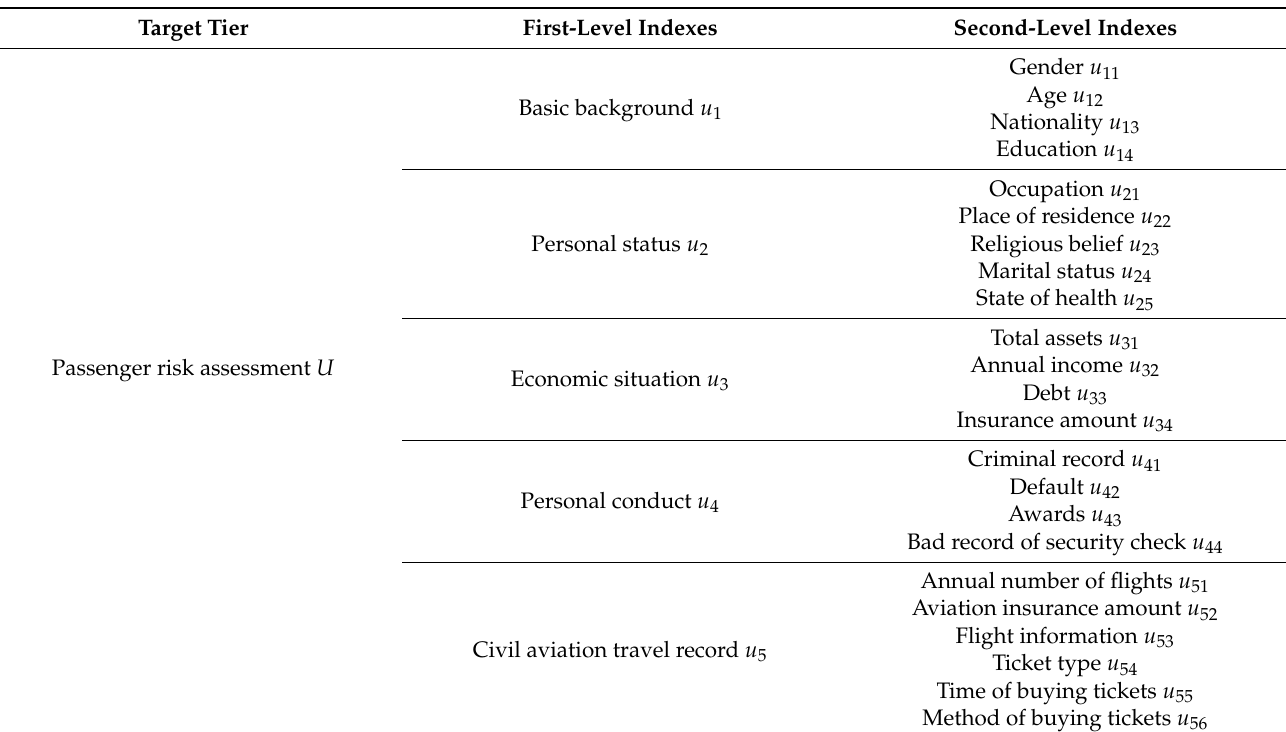
Table 1. Index system of passenger risk assessment.